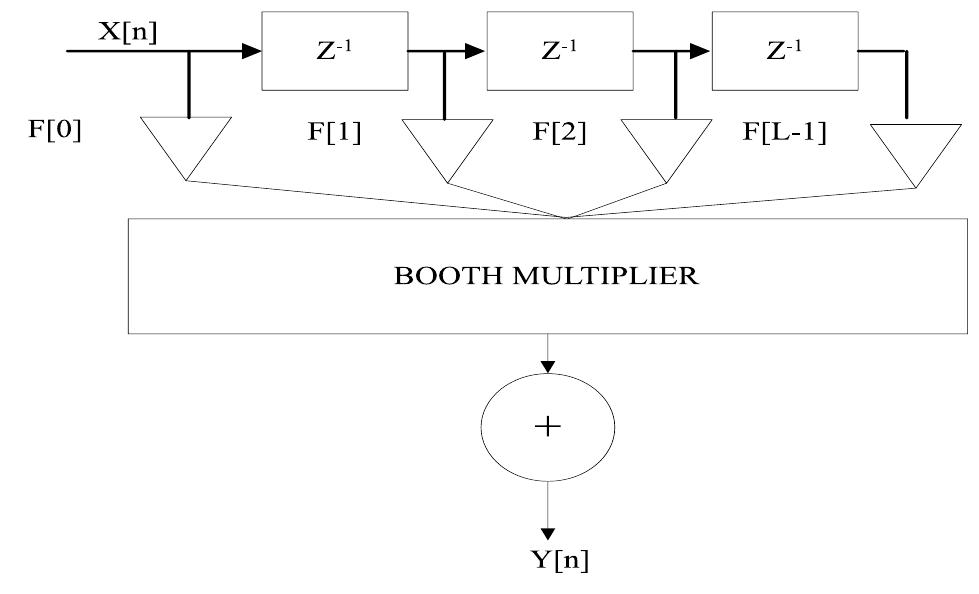
FIG. 3. FIR FILTER DESIGN BOOTH TABLE 1. AREA PERFORMANCE OF CYCLONE FPGA BASED BOOTH MULTIPLIER